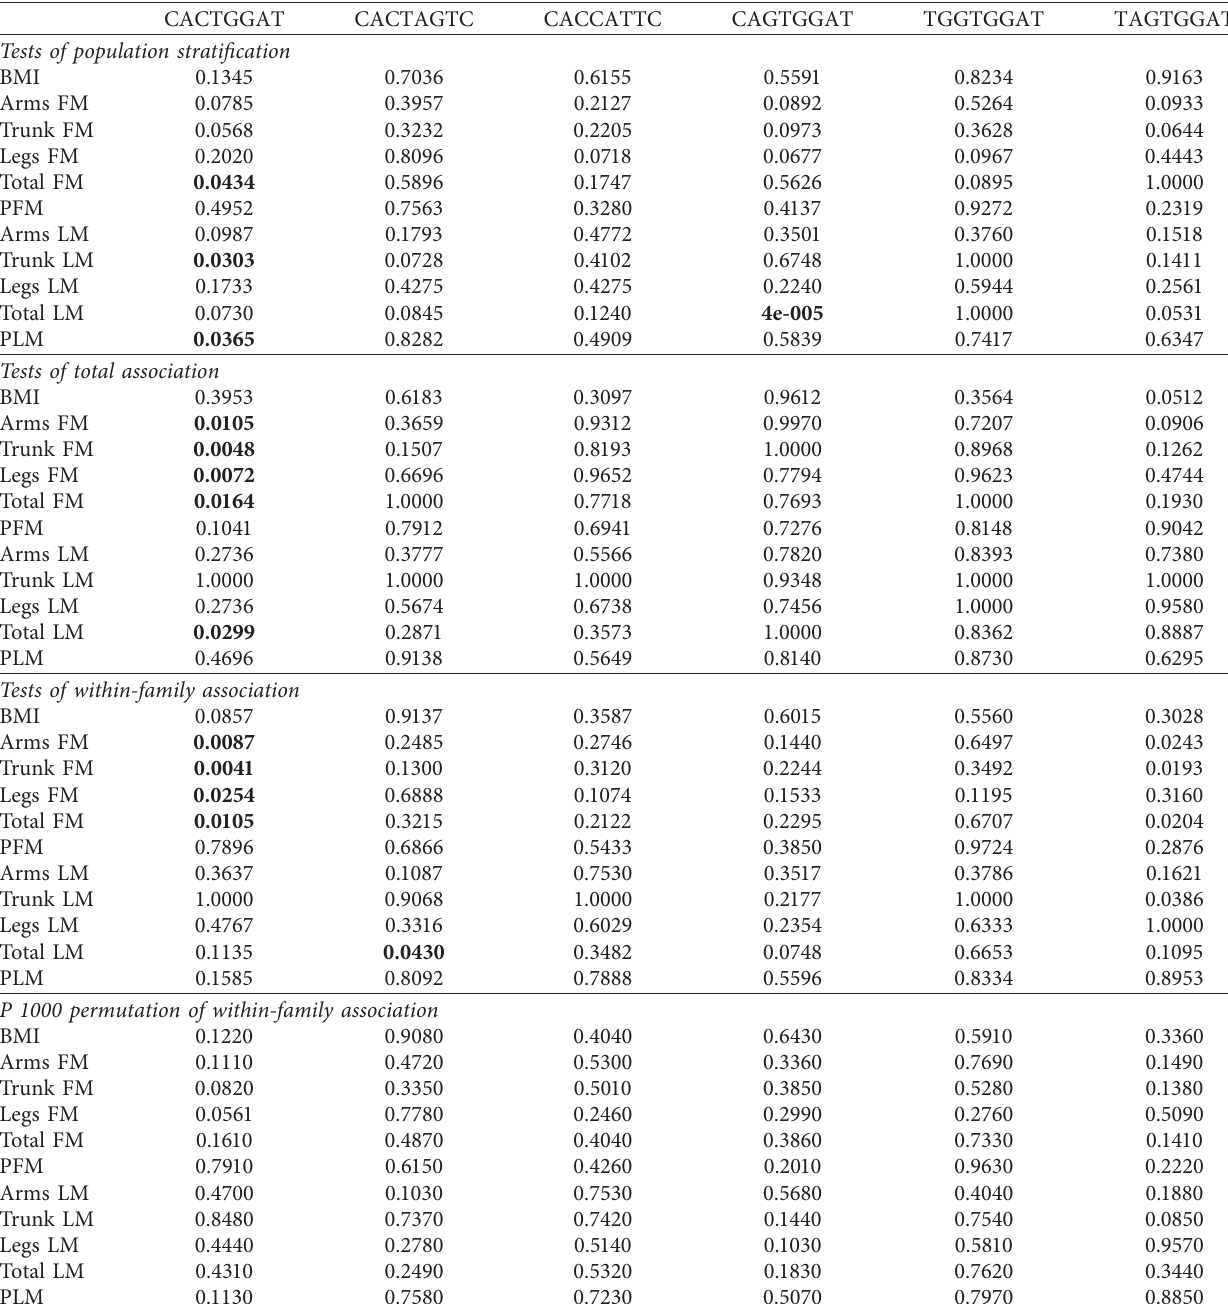
Table 6: P values of tests for population stratification, total association, and within-family association in SOST haplotypes using